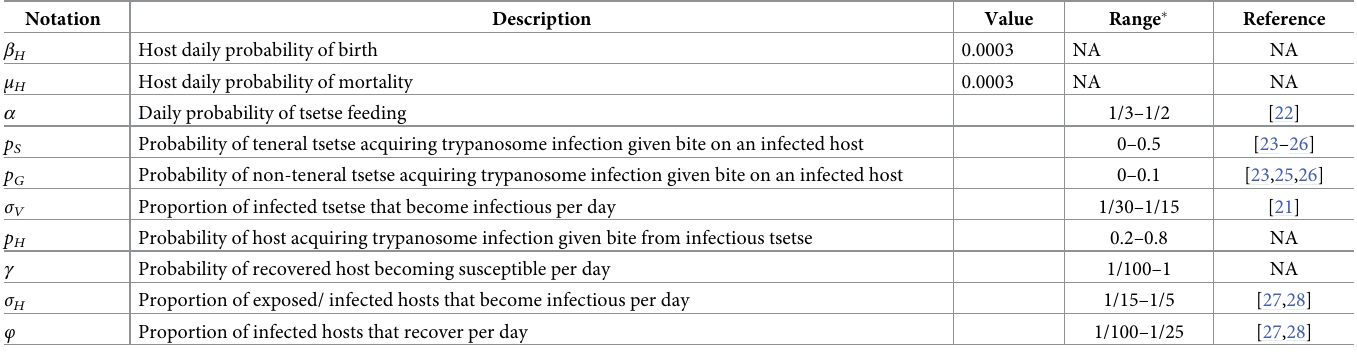
Table 2. Parameters and values used in the trypanosome transmission model. See Table 1 for tsetse population dynamics